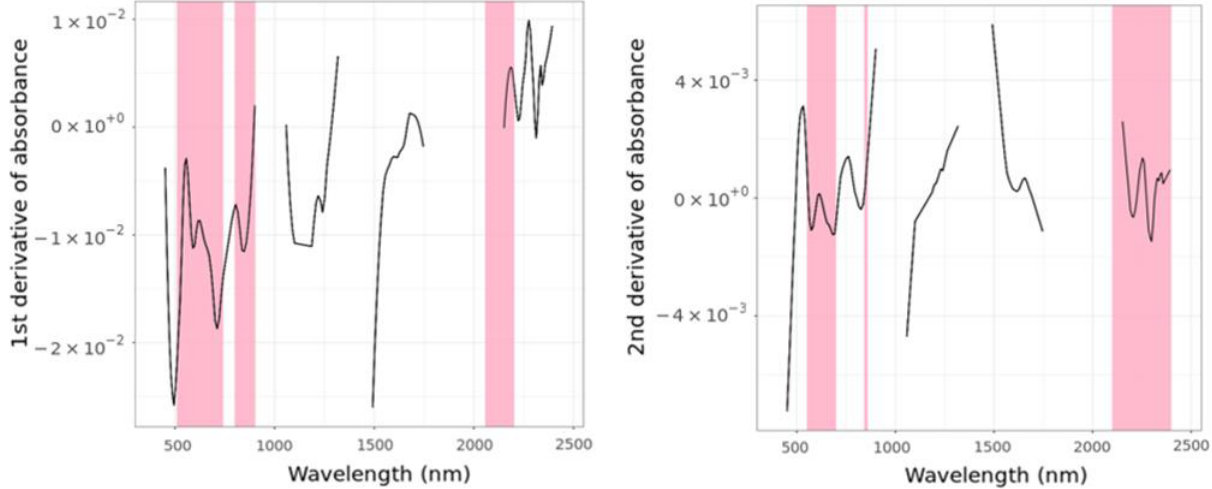
Figure 12. 1st and 2nd derivatives of a PRISMA spectral signature with a high OM content. The important spectral regions are highlighted in pink.